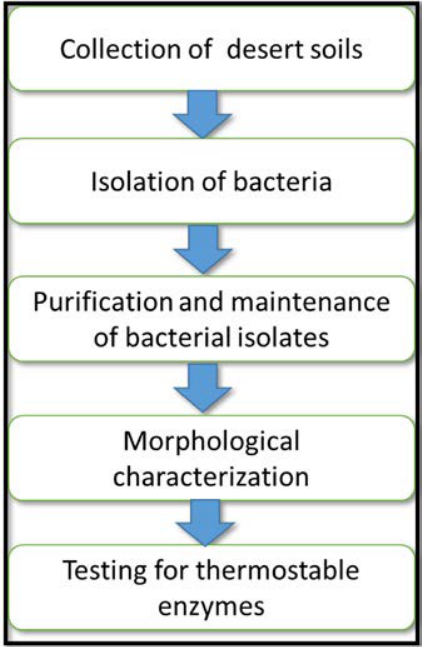
Fig. 1. Design of the experimental work carried out in the current